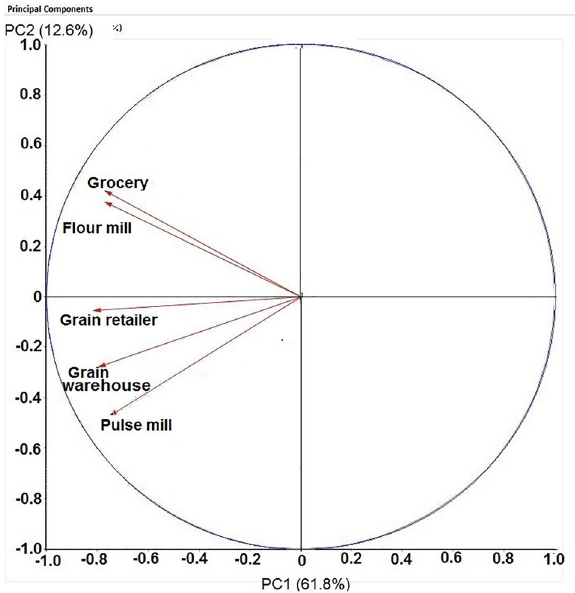
Figure 4. Principal Component Analyses for the weekly counts of Plodia interpunctella adult captures in pheromone-baited traps at different food facilities located in Rajshahi municipality area.